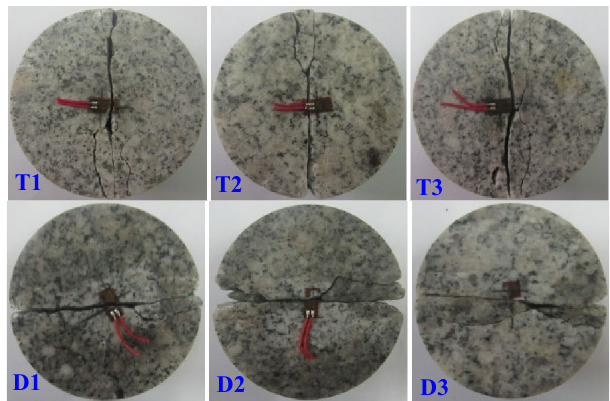
Figure 8. Static and dynamic cleavage failure modes of Brazilian disc.